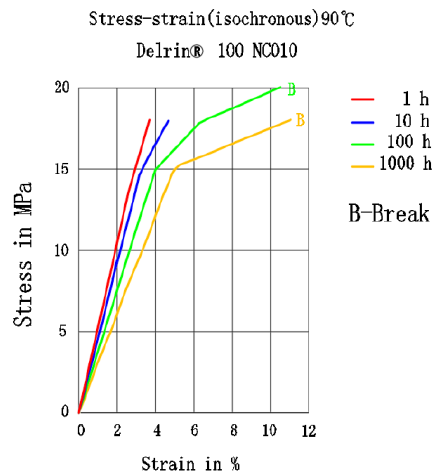
Figure 8. Creep rupture in Delrin ® 100.